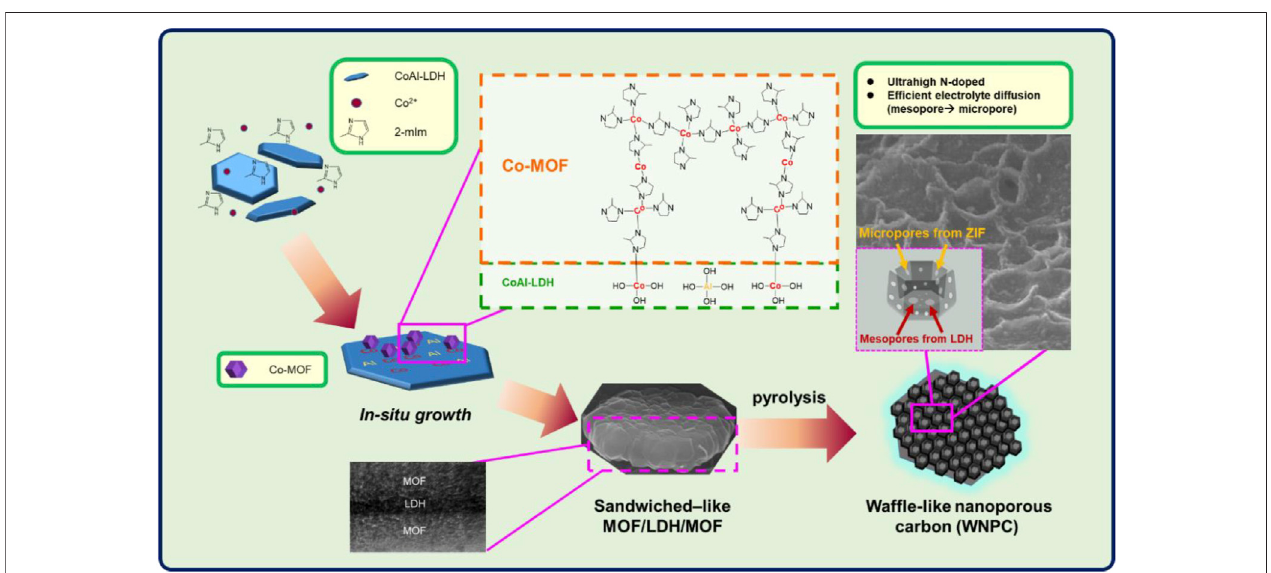
FIGURE 7 | A schematic illustration of the fabrication of sandwiched-like MOFs via in situ growth and the WNPC (Wu et al., 2020). Copyright © 2020 Wu, Chang, Chou, Huang, Liu and Peng.